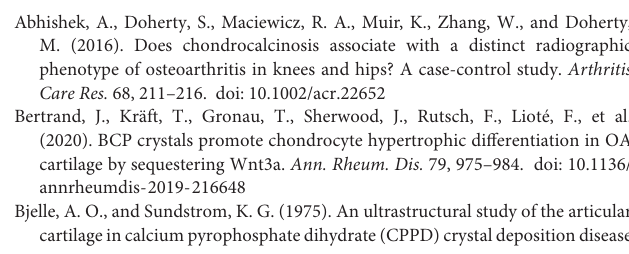
Supplementary Table 1 | Human primers for quantitative real-time